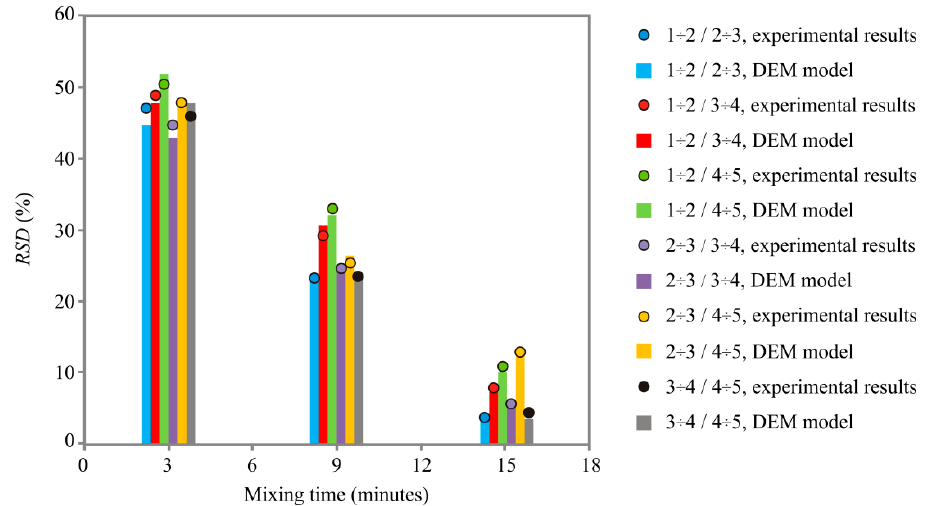
Figure 8. The RSD results obtained in Experiment #3.